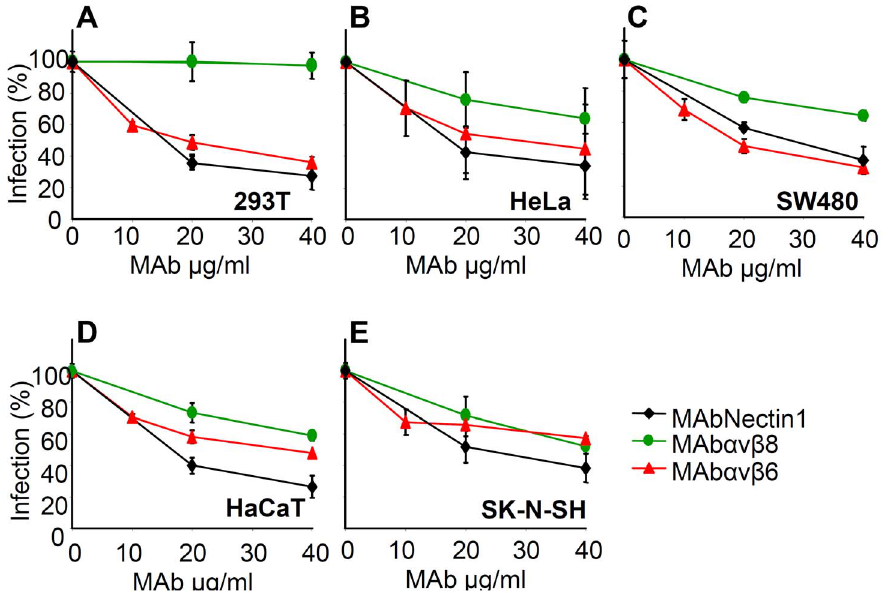
Figure 3. Inhibition of HSV-1 infection by function blocking MAbs to a v b 6- or a v b 8–integrin. 293T (A), HeLa (B), SW480 (C), HaCaT (D), SK- N-SH (E) cells were exposed to increasing amounts of MAb to nectin1 (black diamond), to a v b 6-integrin (red triangle), to a v b 8- integrin (green circle) for 1 h, infected with R8102 (3 pfu/cell) in the same medium, and overlaid with MAb-containing mediun until harvest at 6–8 h after infection. The extent of infection was quantified from Lac-Z gene engineered in the viral genome under the immediate-early a 27-promoter. Extent of b -Gal activity, measured as conversion of ONPG substrate, reflects the amount of infection. Each point represents the average of triplicates. ONPG conversion was measured by O.D. reading at 405 nm [5]. 100% infection is the value obtained with murin IgG used as a control. Bars show